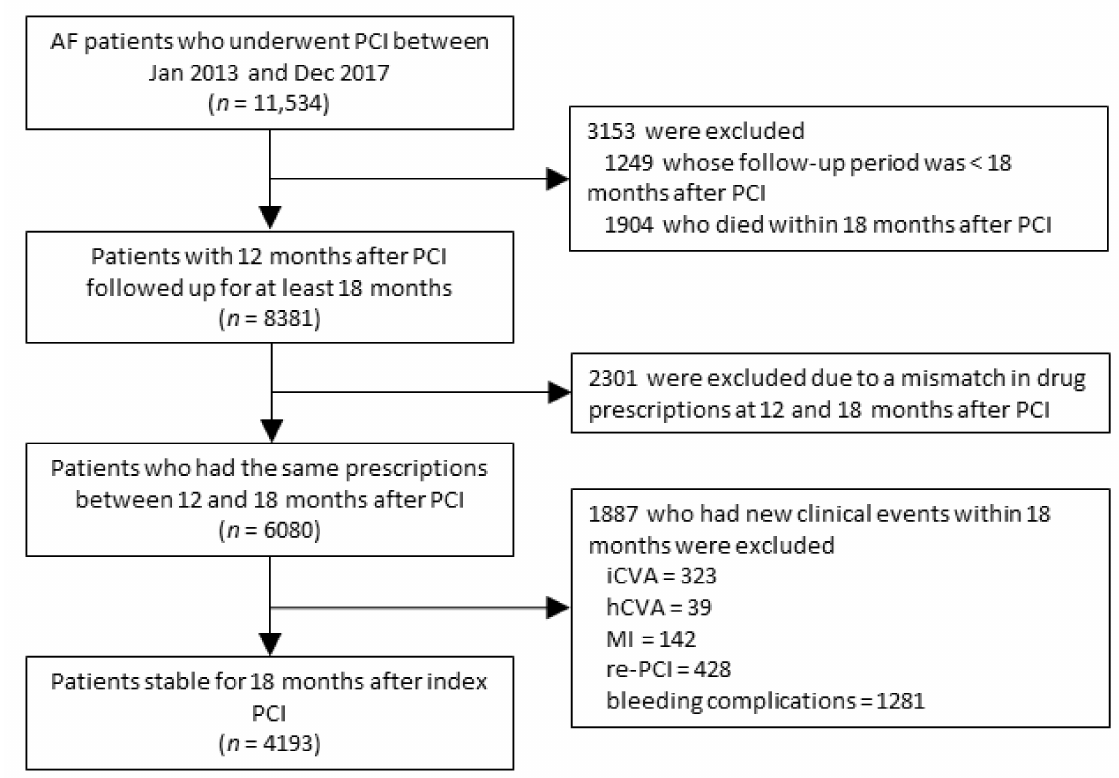
Figure 1. Study enrollment flow. AF, atrial fibrillation; hCVA, hemorrhagic cerebrovascular accident; iCVA, ischemic cerebrovascular accident; MI, myocardial infarction; PCI, percutaneous coronary